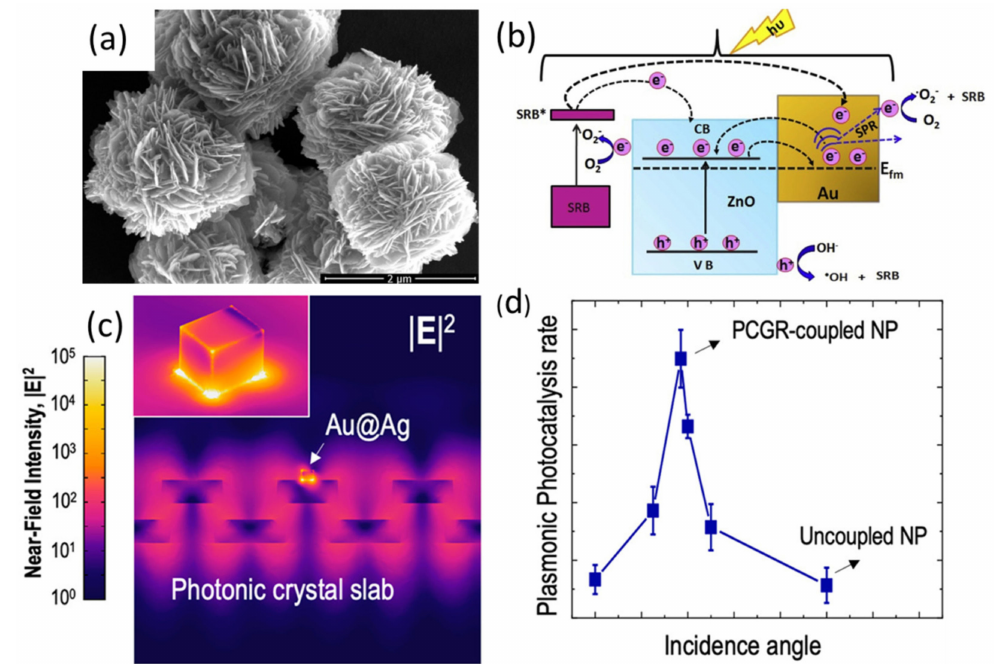
Figure 4. Hybrid plasmonic–photonic nanostructures. ( a ) FE-SEM images of ZnO / Au (1mol %) nanoflower structure and ( b ) the transfer of the electron–hole pair in the ZnO / Au nanostructures shown in the schematic band diagram, responsible for the solar-irradiation-induced degradation of sulforhodamine B. Reproduced with permission from [50]. Copyright Elsevier, 2019. ( c ) Simulated near-field intensity of the Au@Ag–PC hybrid at θ = 3.5 ◦ , and ( d ) measured (1-reflectance-transmittance) spectra of the Au@Ag–PC hybrid at various incidence angles. Reproduced with permission from